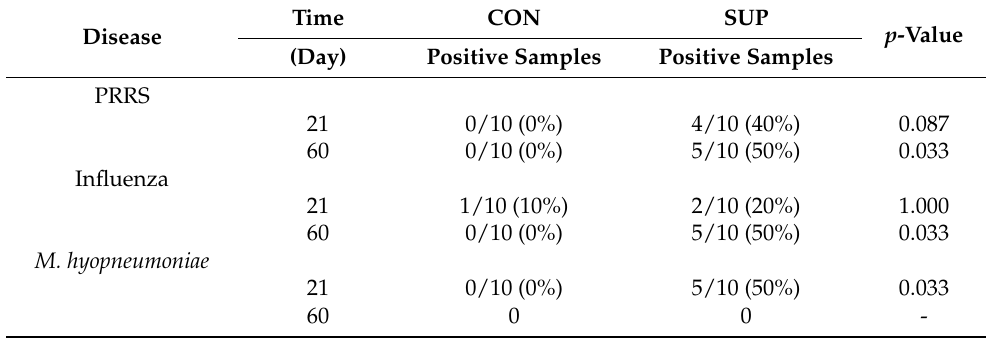
Table 9. Presence of antibodies against PRRS, influenza, and M. hyopneumoniae in 10 individual blood samples from the CON and SUP groups. CON: control group; SUP: colostrum supplemented group. Comparisons between groups were made by using Fisher ´ s exact test.